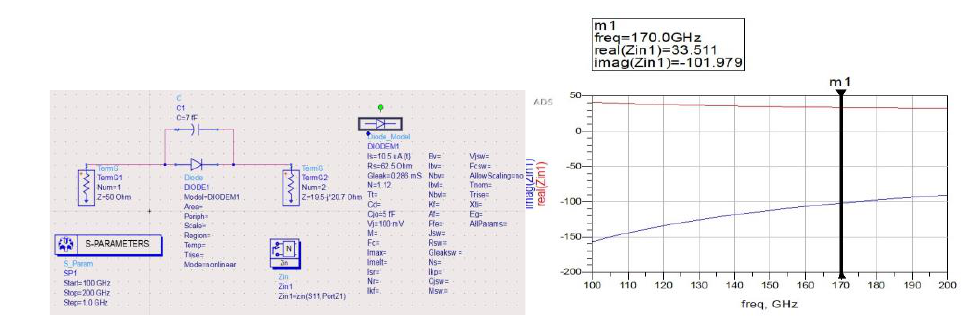
Figure 7: Diode input impedance simulation Figure 6: Diode model of VDI G-band ZBD results